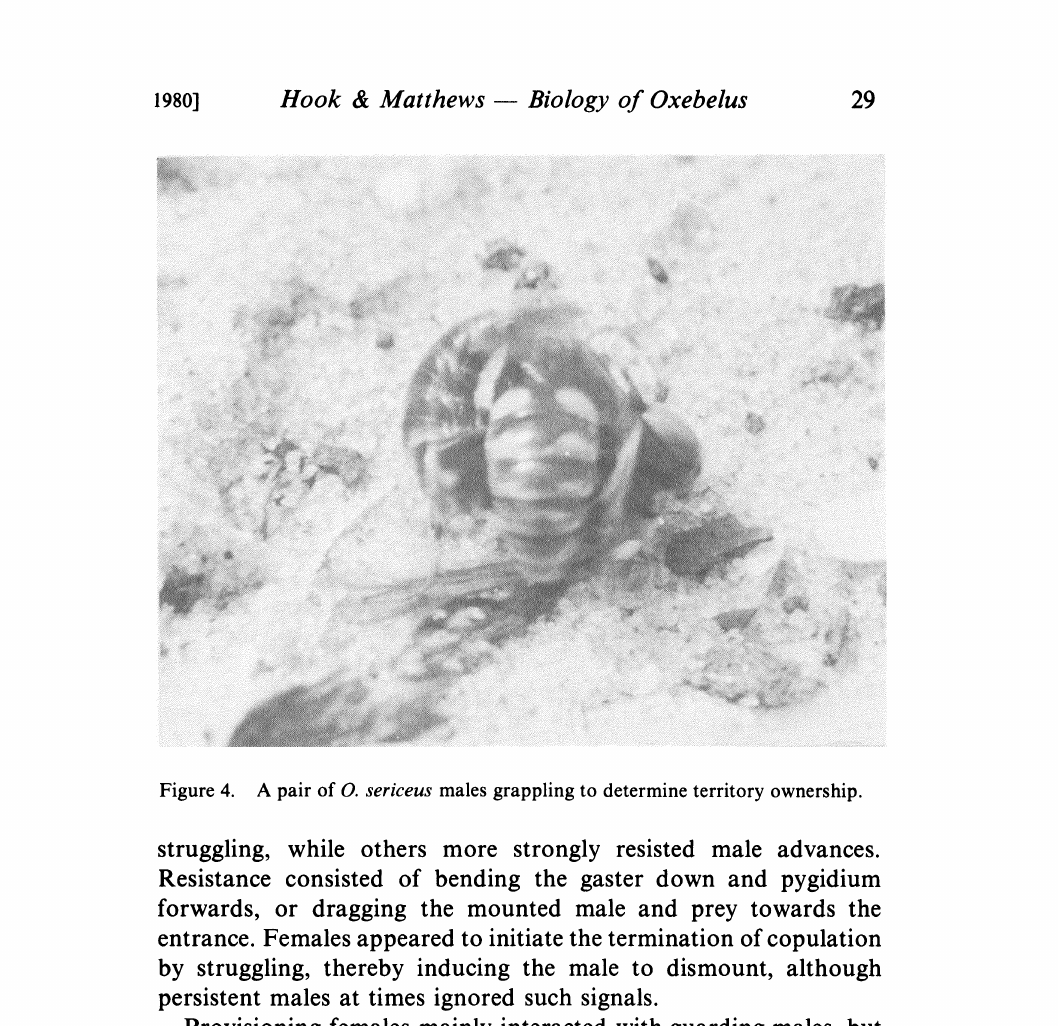
Figure 4. A pair of O. sericeus males grappling to determine territory